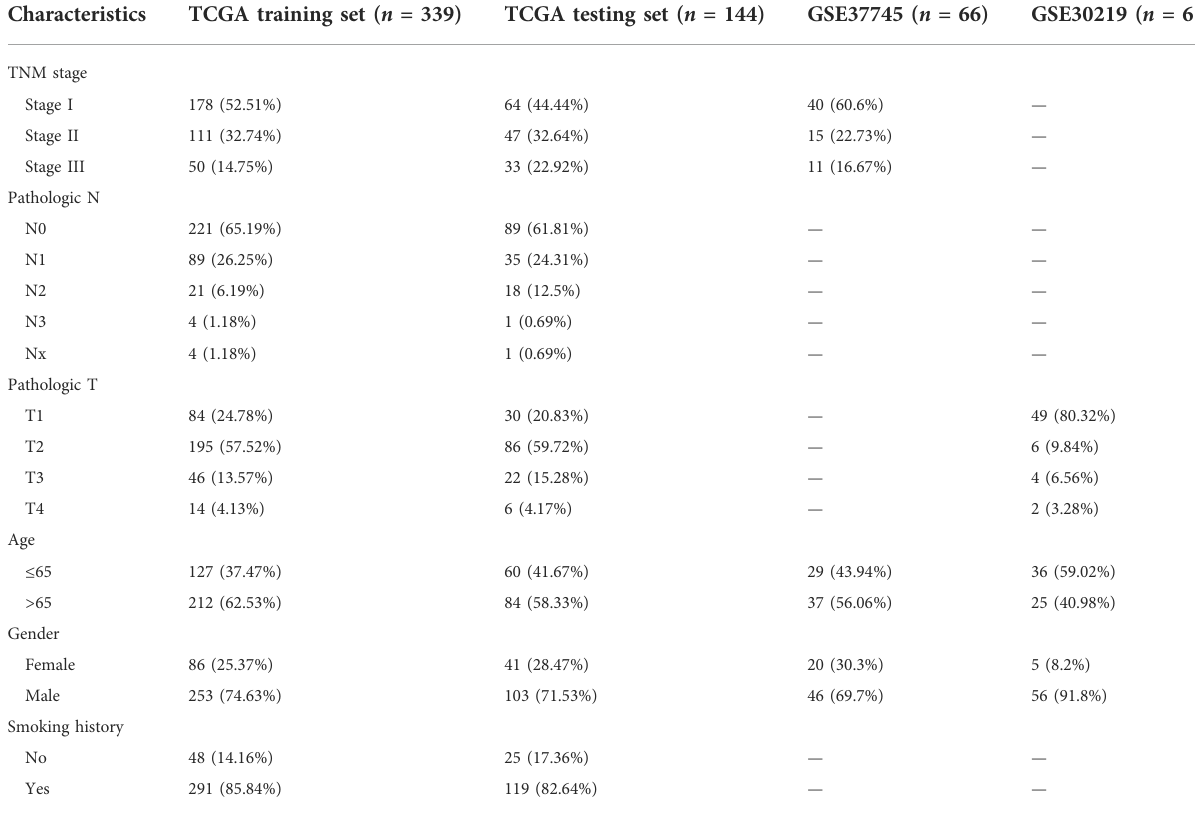
TABLE 1 Clinicopathological characteristics of LUSC patients from TCGA and GEO cohorts.